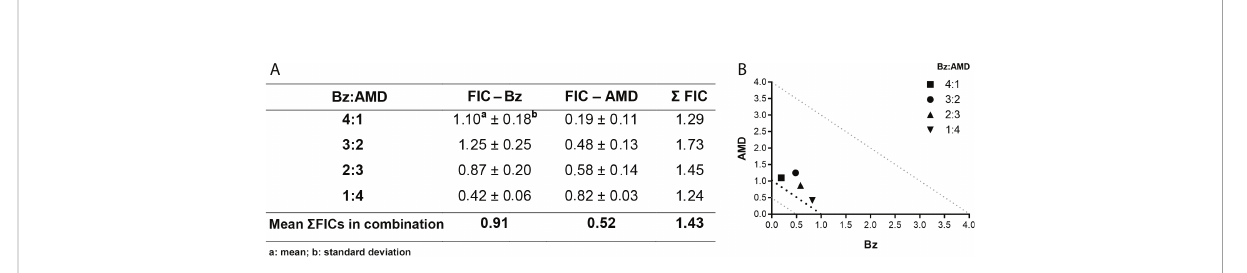
FIGURE 2 Effect of the combination Bz + AMD on BT forms of T. cruzi (Y strain) after 24 h of treatment, demonstrating the addictive interaction (0.5 < S FICs ≤ 4.0). (A) Table showing the mean S FICs of the interaction at the drug ratios tested; (B) Isobologram plotted with the FIC of AMD and Bz on the abscissa and the ordinate,